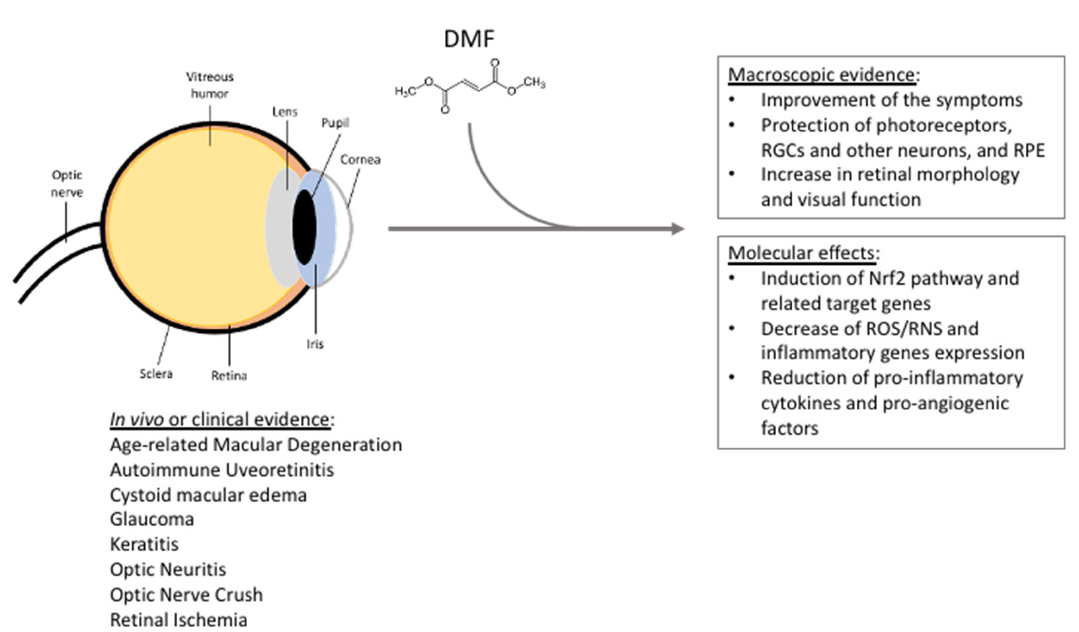
Figure 1. Summarizing scheme reporting DMF beneficial effects in the context of eye pathologies, based on in vivo studies, clinical trials, and clinical and case studies. See the text for further details. RGCs = retinal ganglion cells; RPE = retinal pigment epithelium; ROS/RNS = reactive oxygen/nitrogen species.